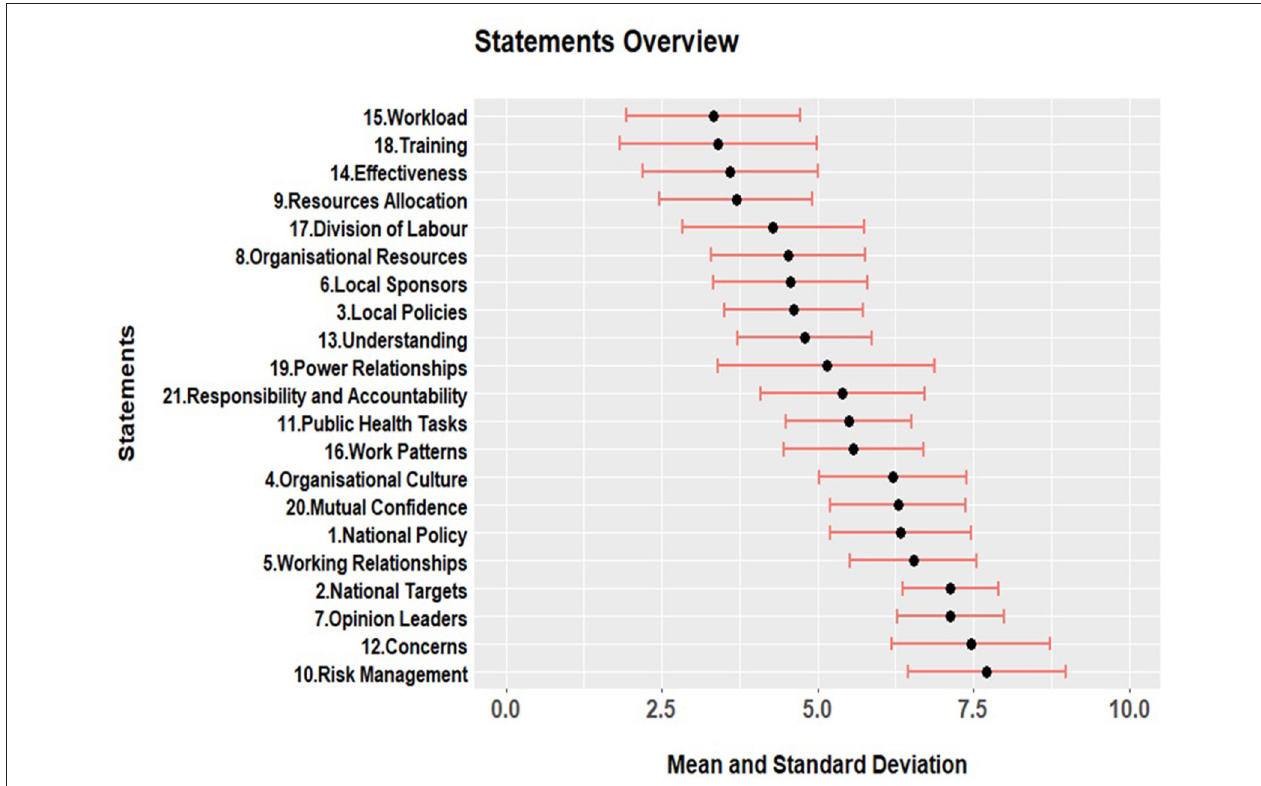
FIGURE 2 | Mean and standard deviation for positive or negative appraisal of complexity approaches in relation to 21 topics. Higher numbers represent positive